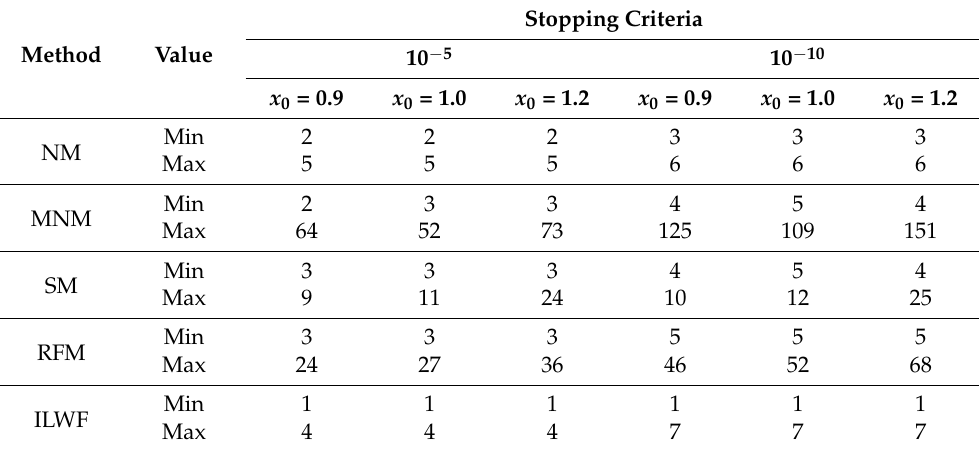
Table 6. Minimum and maximum number of iterations for the iterative methods used observing all measured points of Photowatt-PWP201 modules.